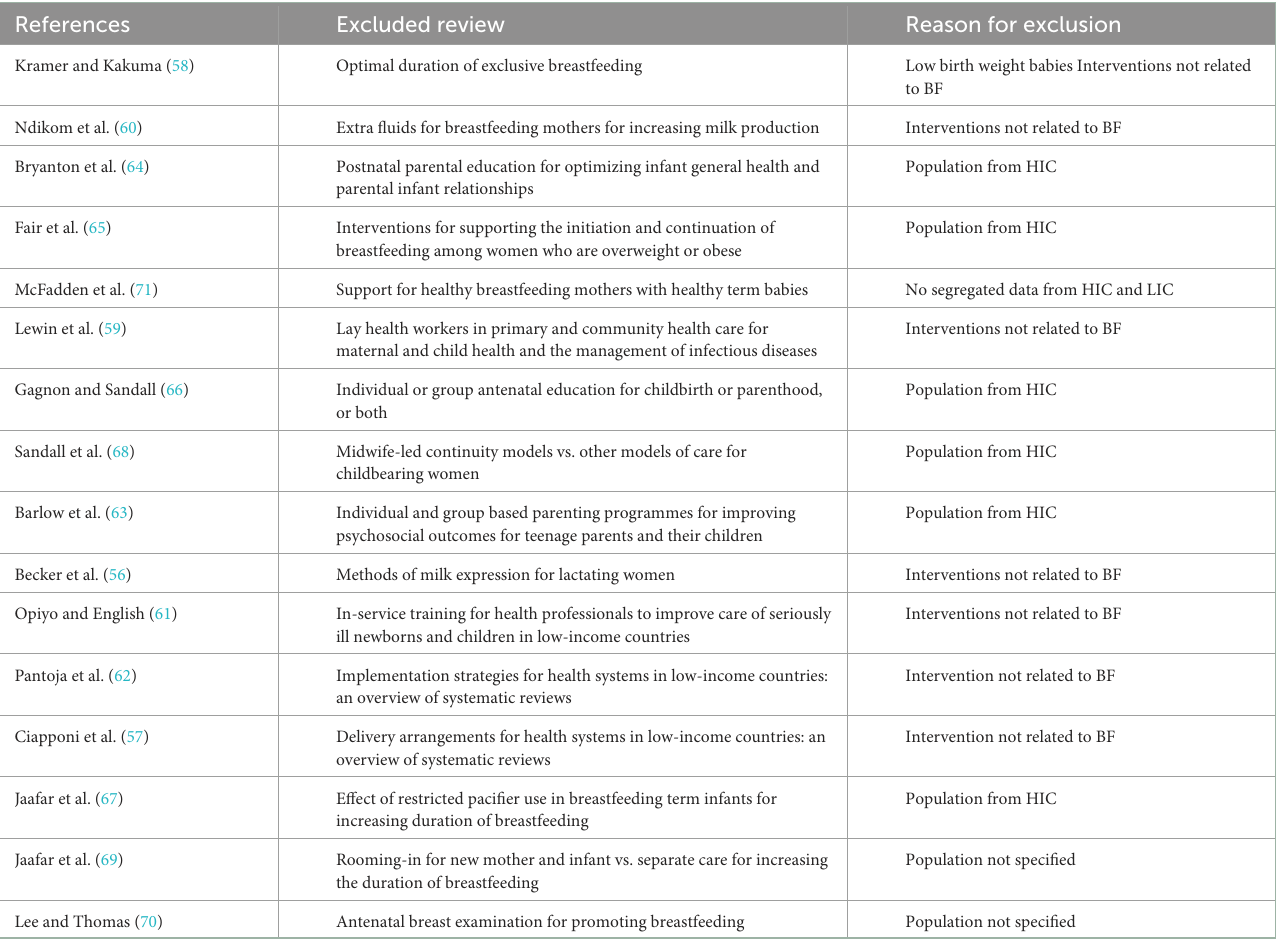
TABLE 4 List of excluded studies with